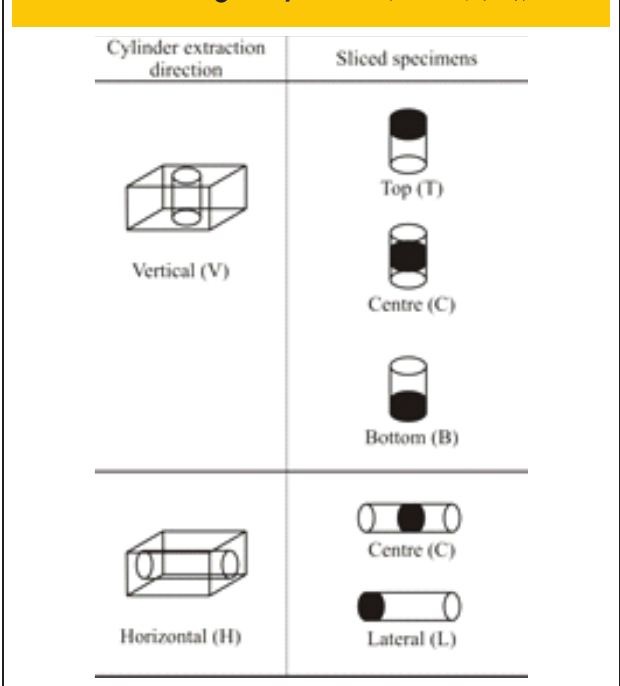
Figure 1 – Preparation of specimens: extraction and cutting of cylinders (Souza, [10])